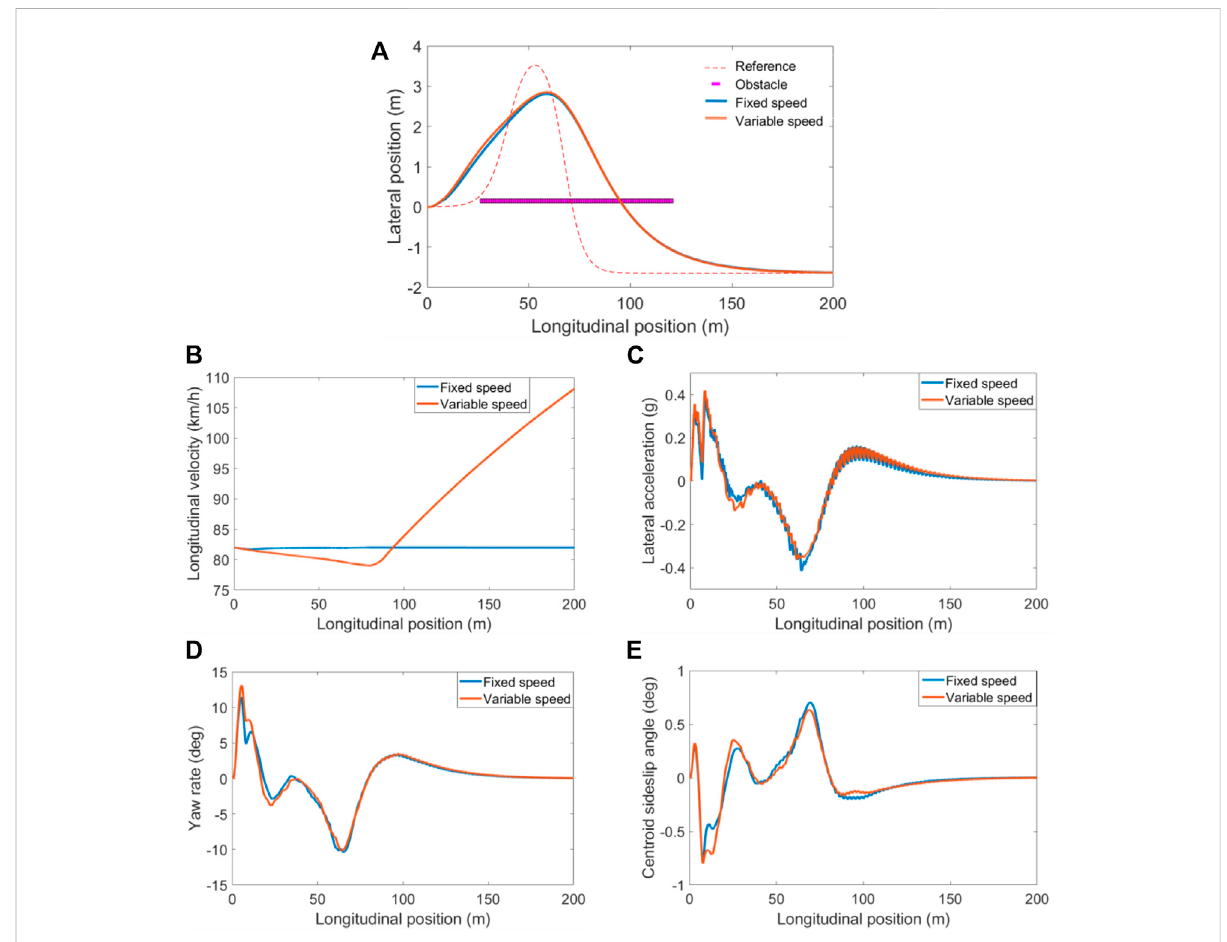
FIGURE 13 Simulation results of scenario B. (A) Tracking trajectory; (B) Longitudinal velocity; (C) lateral acceleration; (D) Yaw rate; (E) sideslip